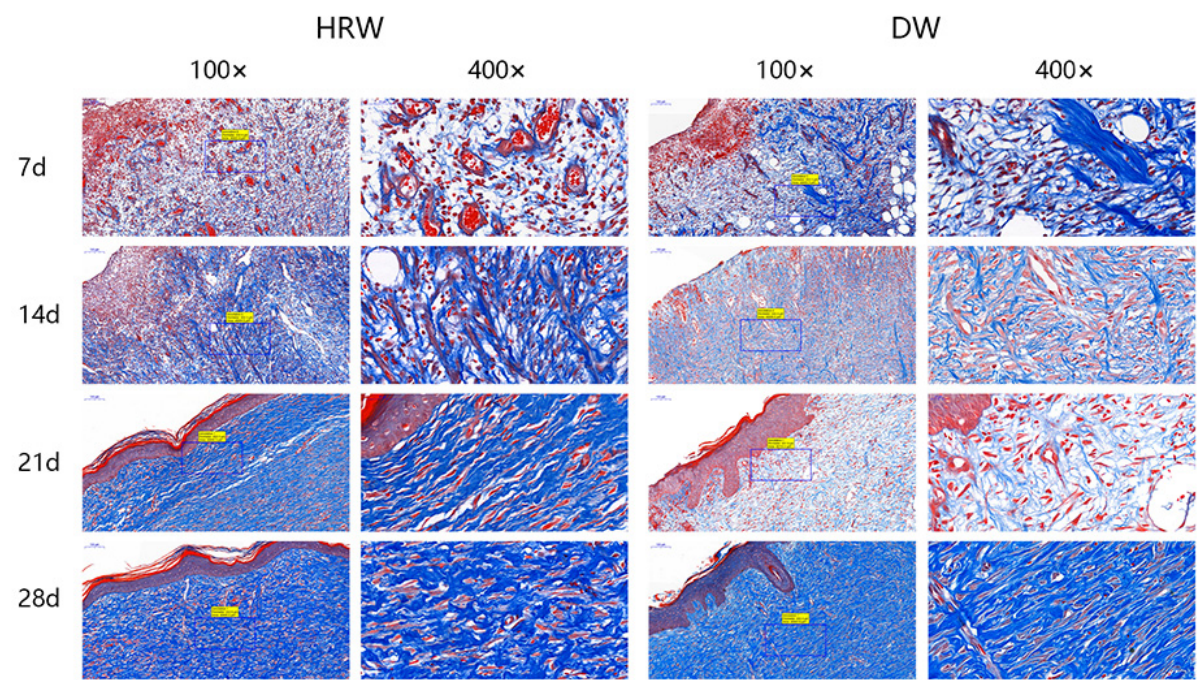
Figure 6. Skin wound paraffin sections were subjected to Masson staining. The collagen fibers were stained blue, and the muscle fibers were stained red after Masson’s trichrome staining.